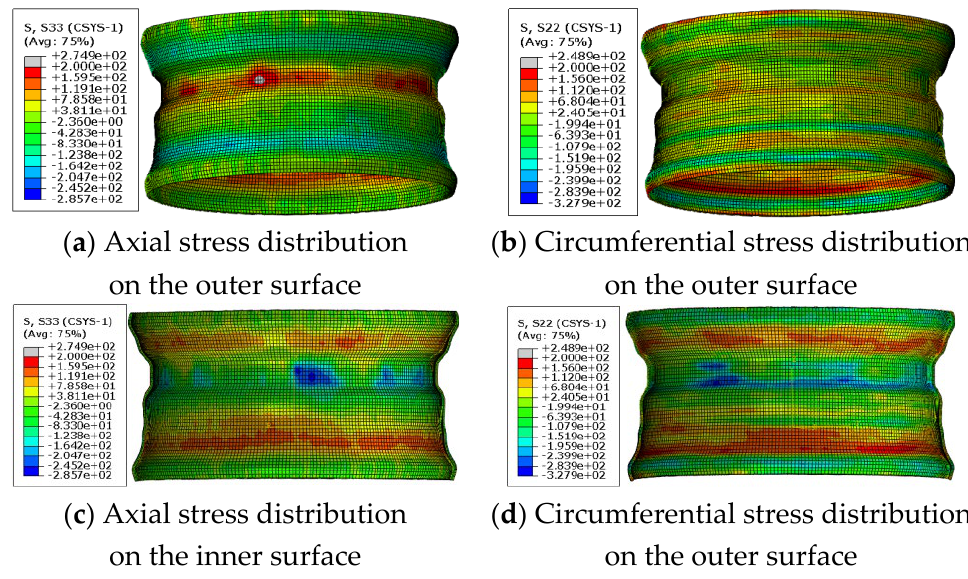
Figure 5. Residual stress distribution after the third rolling.